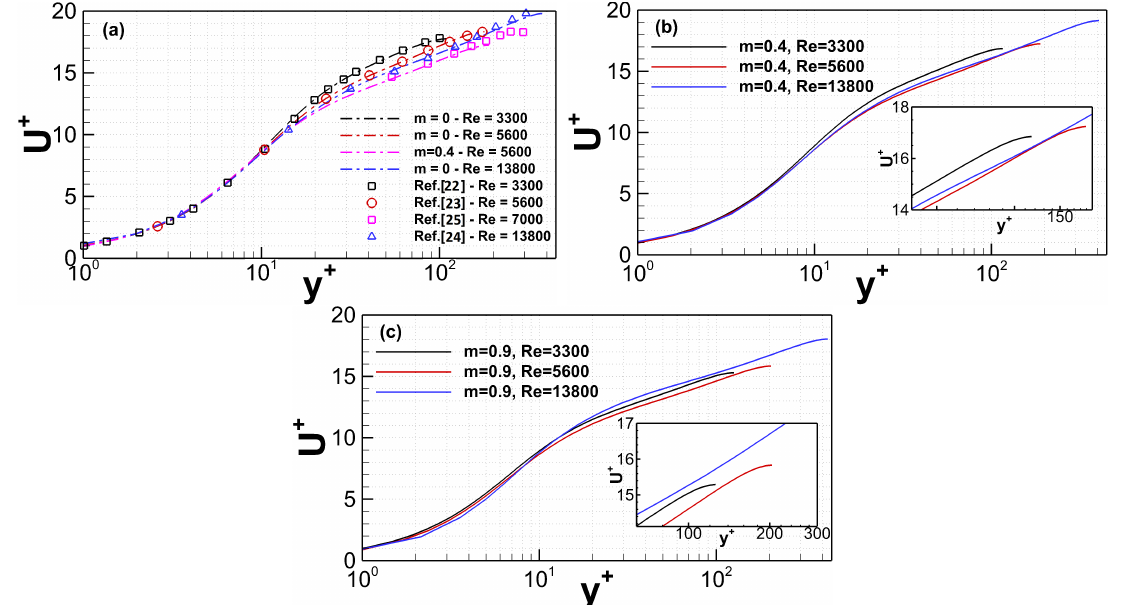
Figure 1. Normalized mean streamwise velocity distributions along y + , for: m = 0, Re = 3300,5600,13,800; m = 0.4, Re = 3300,5600,13,800 and m = 0.9, Re = 3300,5600,13,800 cases plotted against results of